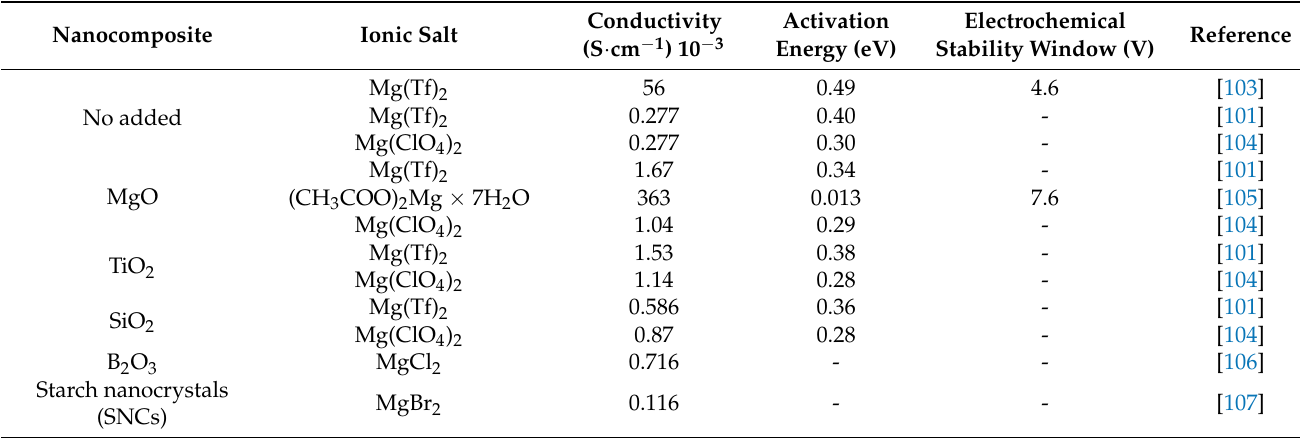
Table 3. A summary of NCPEs composed of PEO for magnesium batteries in solid-state.